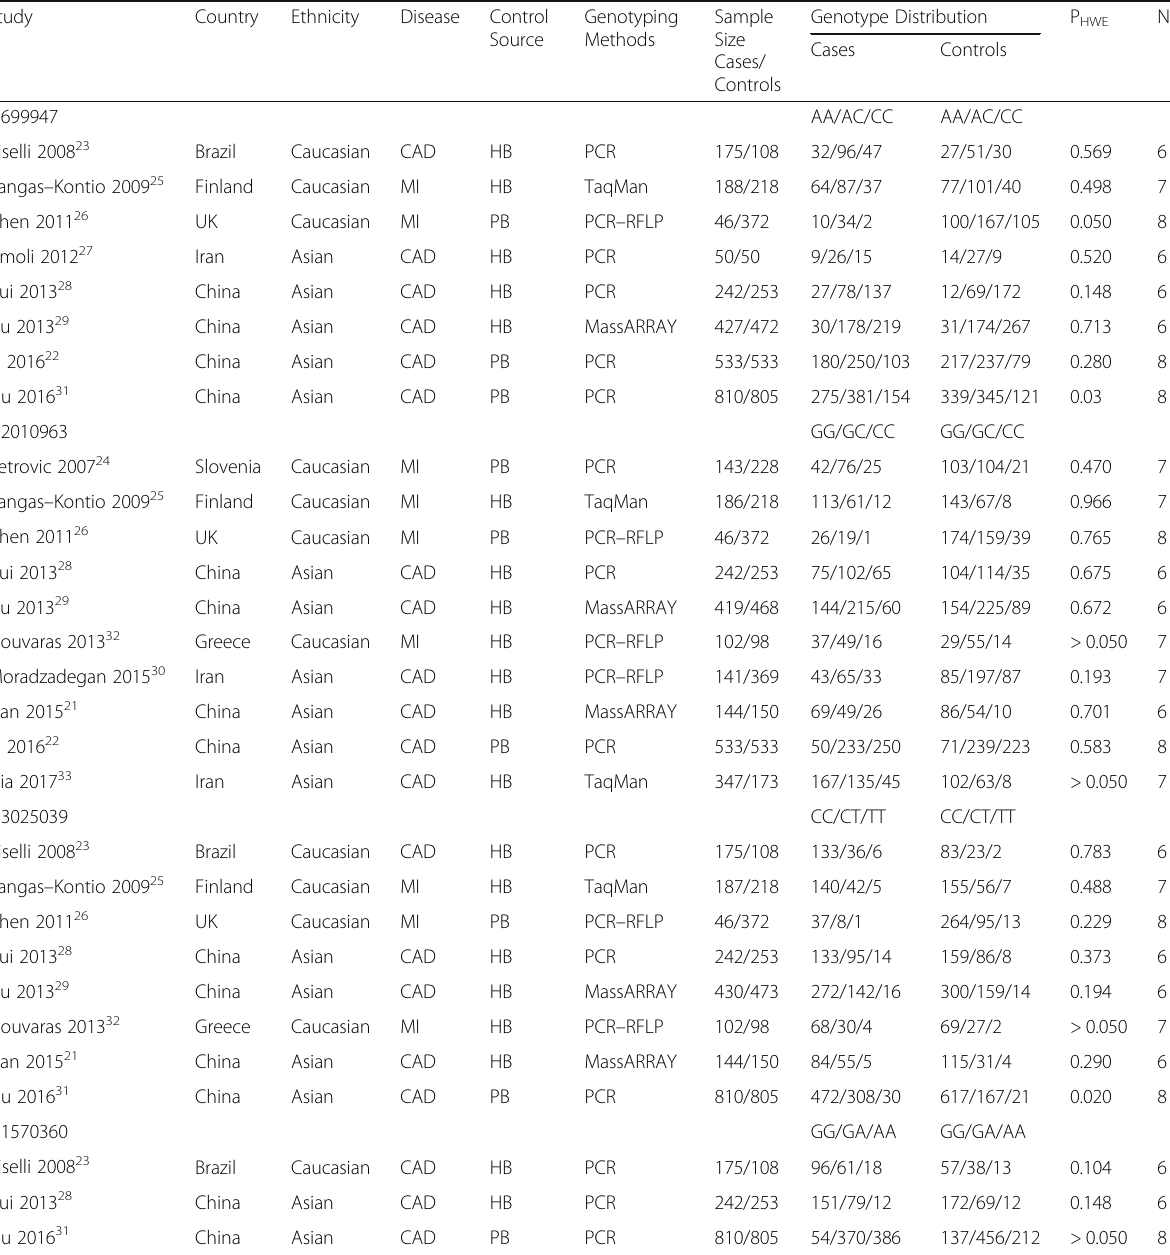
Table 1 Characteristics of the individual studies included in the meta –